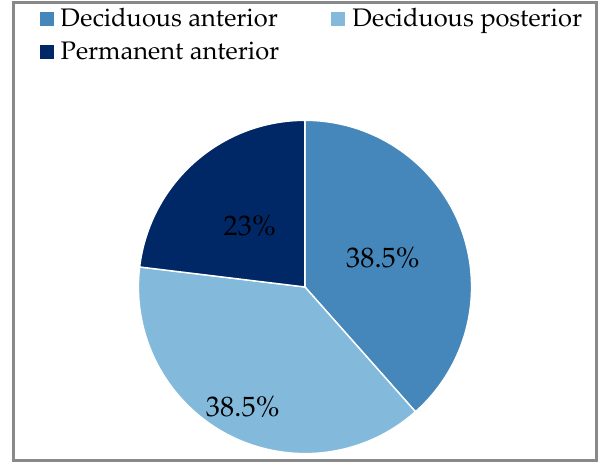
Figure 1. Upper face-source of infection (n = 13).